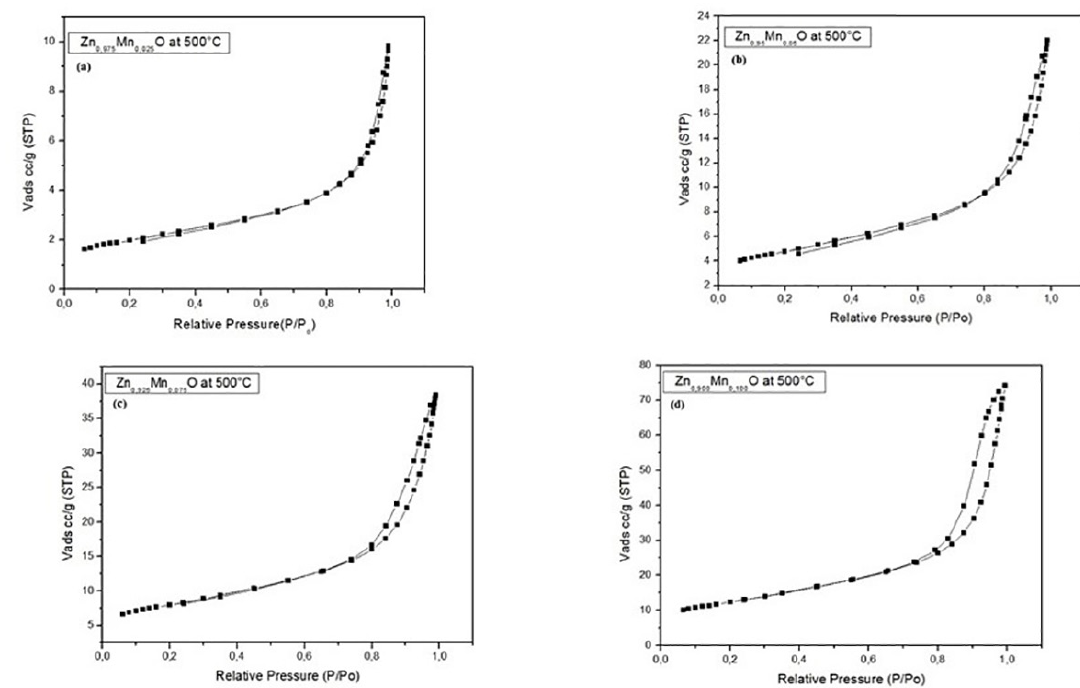
Mn O; 0.975 0.025